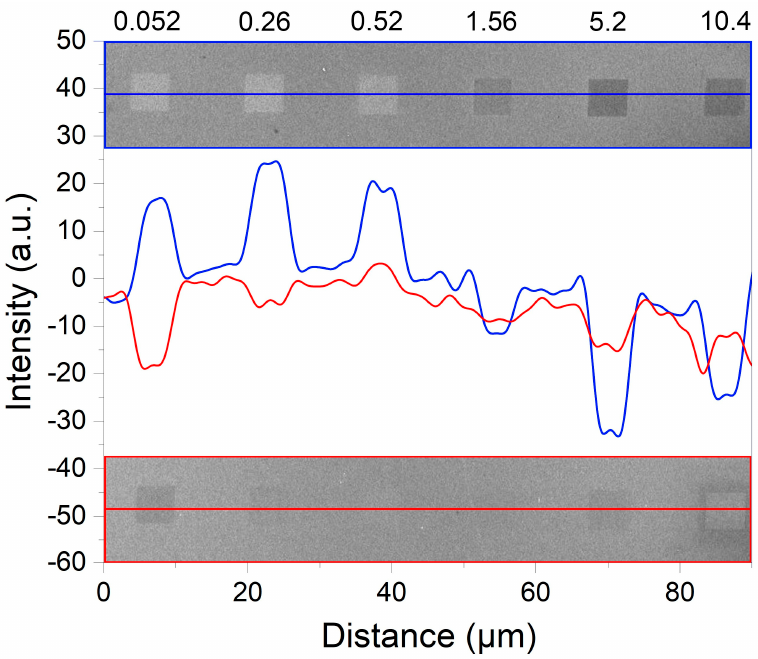
Figure 4. Dependence of the SEM-contrast intensity for each modification area before ( bottom ) and after ( top ) annealing. The top axis shows the doses of Ga FIB treatment (in pC/µm 2 ).